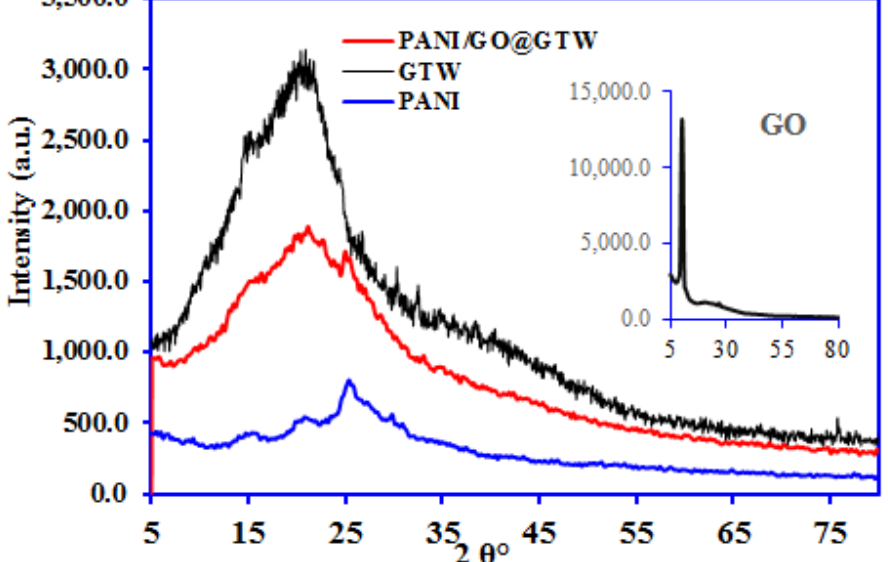
Figure 2. XRD pattern of the GTW, GO (inset), PANI, and PANI/GO@GTW composite. The surface morphology and EDX analysis were performed to examine the surface texture and any changes in the elemental composition after the immobilization of the PANI and GO sheets on the surface of the GTW composite. The SEM images (Figure 3a,b) show the irregular granules of the rough surface of GTW, and the C, O, Ca, and S elements were observed by EDX analysis (Figure 3c). After the PANI and GO immobilization on the GTW surface, the adherence of small particles can be seen (Figure 3d). The magnified image of the PANI/GO@GTW composite showed the porous structure of the PANI, GTW, and GO sheets are visible. The elements on the PANI/GO@GTW composite surface were observed as C, O, N, Cl, and S. The Pt presences in both materials were due to the Pt coating before the SEM analysis. Moreover, Ca was not observed in the PANI/GO@GTW composite, probably due to its solubilization in the presence of HCl at the synthesis time. The identification of elemental compositions and their oxidation states was done using the XPS technique. The wide scan survey of the PANI/GO@GTW composite is shown in Figure 4a, indicating the presence of the C—75.7%, O—15.4%, N—7.6%, and S—1.2% for the C1s, O1s, N1s, and S2s, respectively. The deconvolution of the C1s (Figure 4b) indicates the presence of the C-C (184.33 eV), C-N/C = N (286.12 eV), and C = O (289.14 eV) groups which belong to the GO, PANI, and GTW [30]. Figure 4c indicates that several peaks for the deconvoluted N1s correspond to N + (401.7 eV), and NH + (403.1 eV) [31]. The XPS spectra of O1s showed the two peaks at 529.68 eV and 531.8 eV, indicating the presence of C-O and C = O related groups in the GO and GTW as shown in Figure 4d [32]. The XPS analysis confirmed the surface elements of the PANI/GO@GTW composite that are present in the synthesized